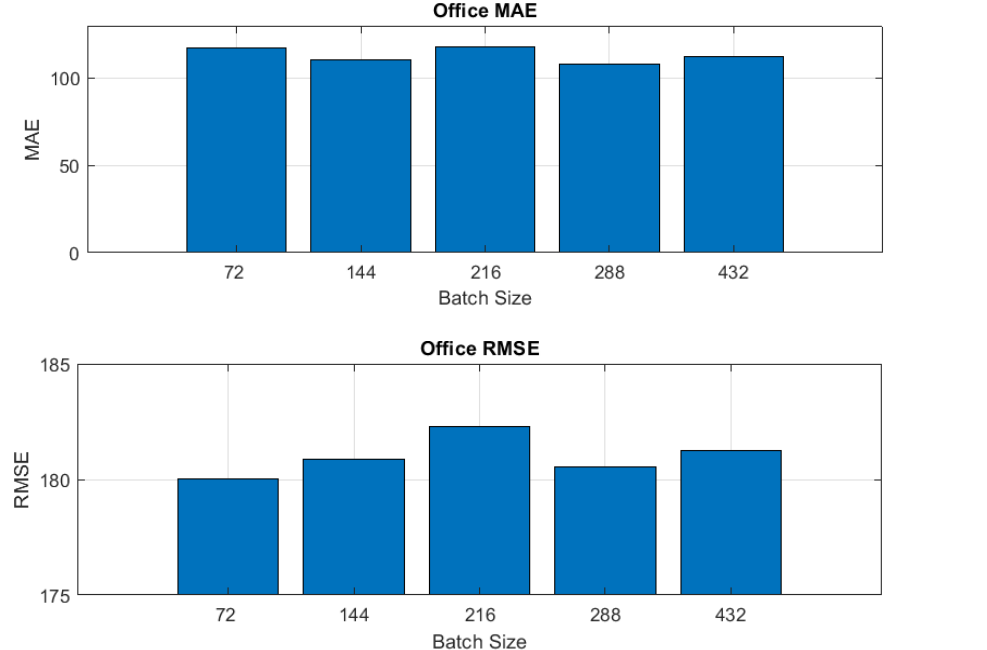
Figure 6. Metrics for the Office case: Office MAE and Office RMSE.